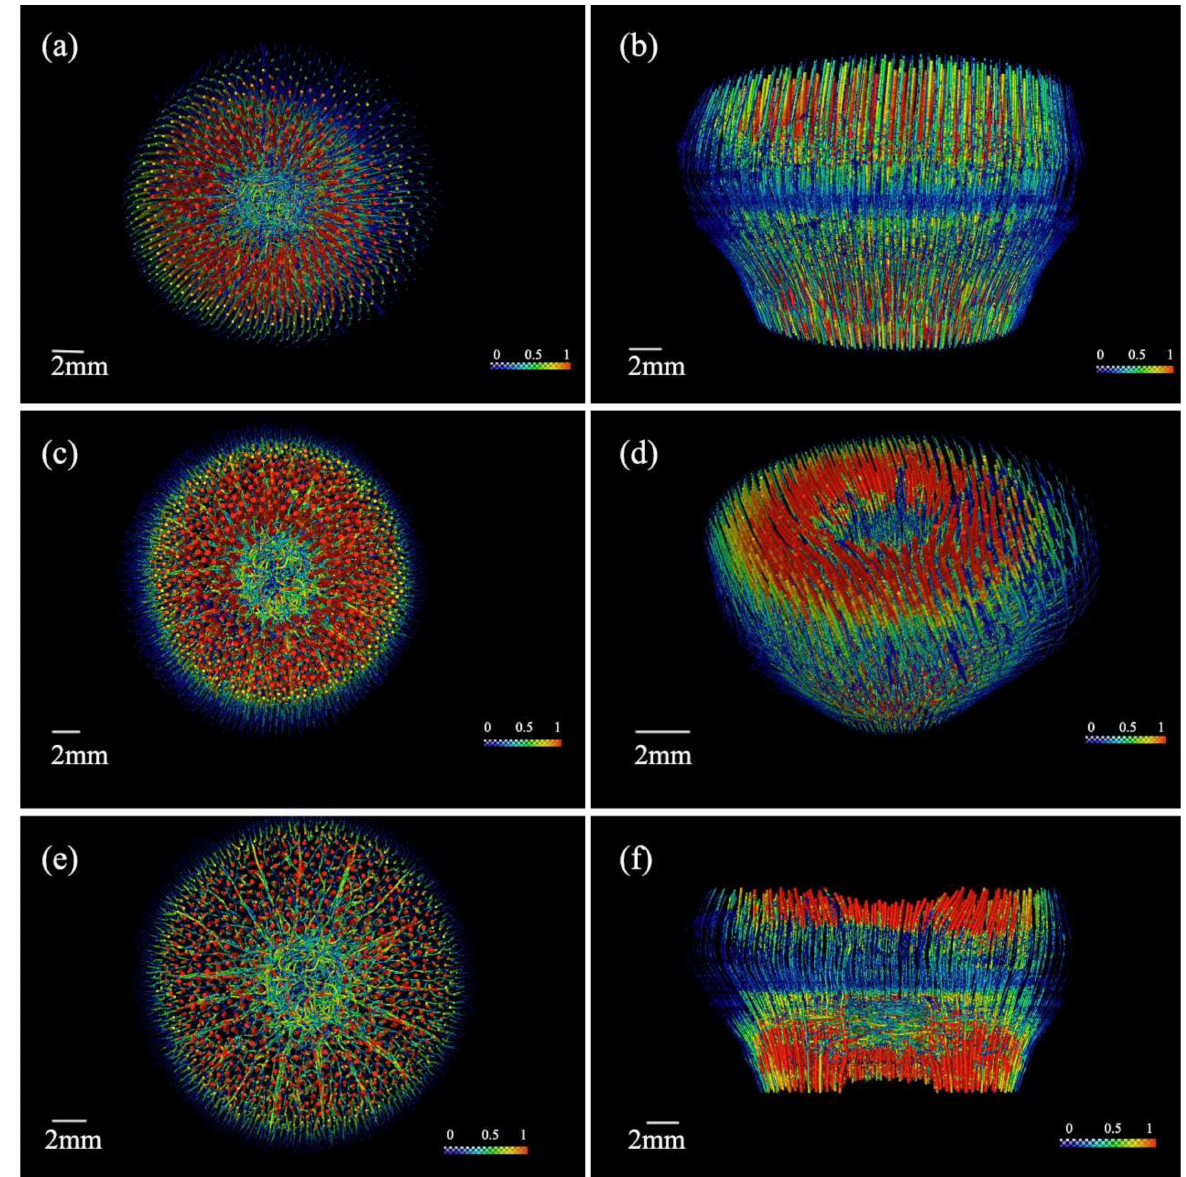
Figure 8. Three-dimensional skeleton conducting tissue in the node. ( a ) Top view. ( b ) Side view. ( c ) Bottom view. ( d ) 3D skeleton. ( e ) View of the transverse section. ( f ) View of the longitudinal